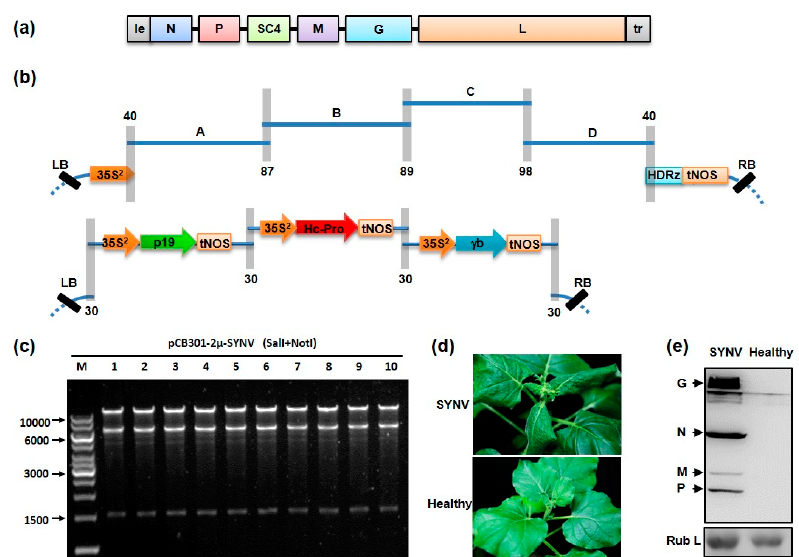
Figure 2. Construction of cDNA clones by homologous recombination (HR) in yeast for recovery of recombinant sonchus yellow net virus (SYNV): ( a ) Diagram depicting the SYNV antigenomic RNA. Six viral genes ( N , P , sc4 , M , G and L ) are flanked by the 5 ′ leader (le) and 3 ′ trailer (tr) sequences; ( b ) Schematic representation of the yeast HR-based cloning strategy. In the upper panel, four overlapping SYNV cDNA fragments (A, 3584 bps; B, 3637 bps; C, 3370 bps; D, 3439 bps) and the linearized vector pCB301-HDV-2 μ are shown. After assembly, viral cDNA is positioned precisely between the 35S promoter (35S 2 ) and HDV ribozyme (HDRz). The lower panel shows the assembly scheme for the tandem arrayed expression cassettes of the tomato bushy stunt virus p19, tobacco etch virus HC-Pro and barley stripe mosaic virus γ b viral suppressors of RNA silencing. The overlapping regions are depicted by gray shadow boxes, with the number of overlapping nucleotides indicated. Note that all of the fragments in the figure are not drawn exactly to scale; ( c ) SalI and NotI double digestion of ten recombinant plasmids. The positions of the 10,000, 6000, 3000 and 1500 bps size marker (M) are indicated to the left of the panel; ( d ) Symptoms of N. benthamiana plant infected by recombinant SYNV at 35 days post infiltration. Healthy: an uninfected plant; ( e ) Total proteins extracted from systemically infected leaf tissues were analyzed by Western blotting using an antibody against SYNV virions. The Coomassie blue-stained Rubisco larger submit (Rub L) is shown as loading control.